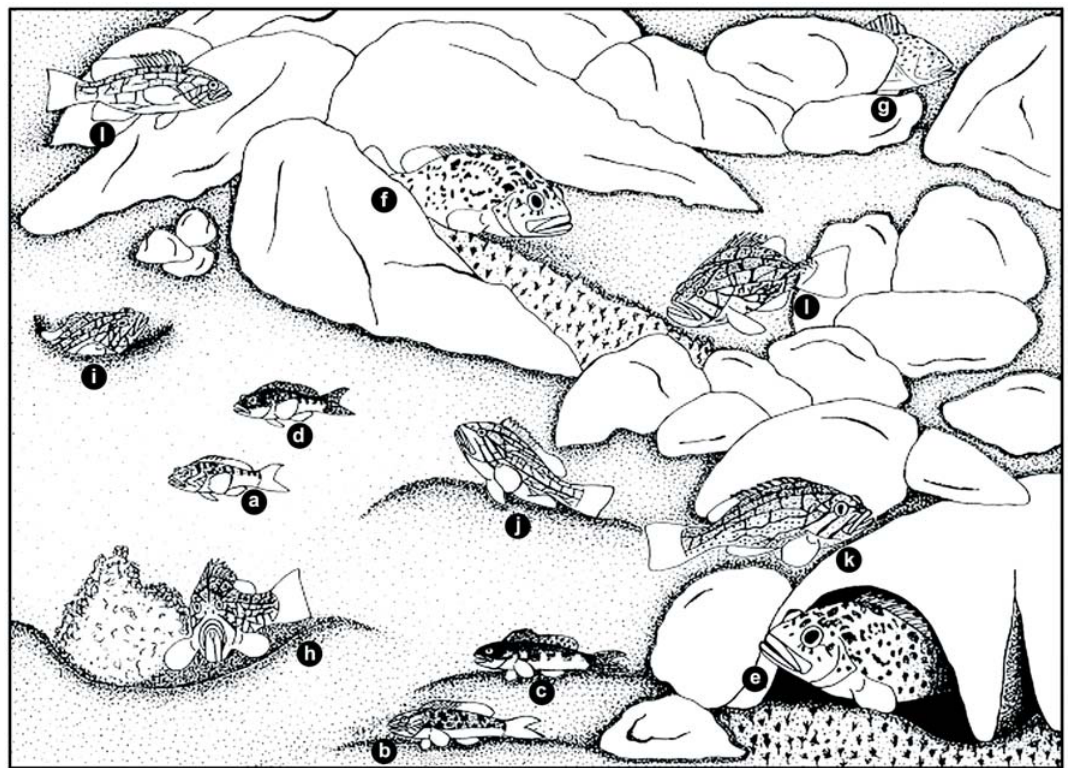
Fig. 1. Habitat partitioning by the four studied serranids during their feeding activity phases. Diplectrum formosum (a-b); Diplectrum radiale (c-d); Epinephelus marginatus (e-g); and Mycteroperca acutirostris (h-l). There is no scale among the fishes or between them and the